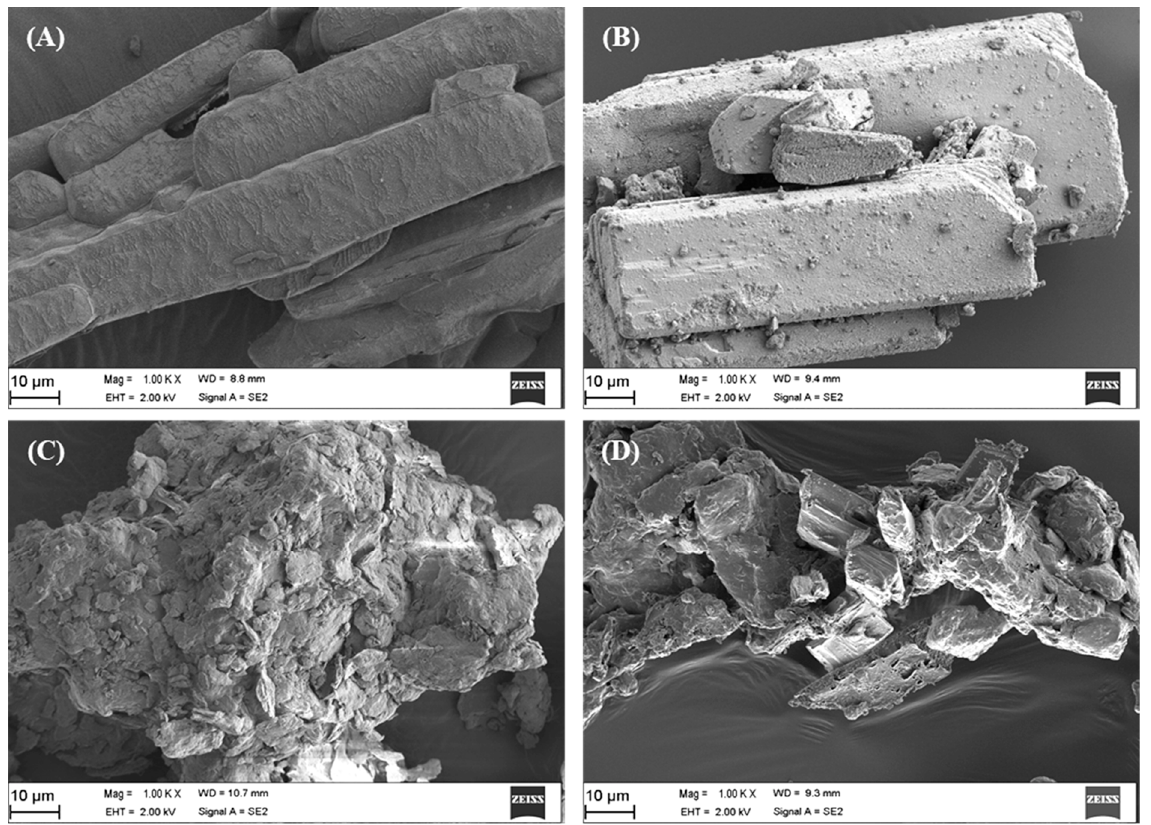
Figure 7. Scanning electron micrographs of: ( A ) pyrazinamide, ( B ) rifampicin, ( C ) placebo and ( D ) drug loaded suspension powder formulation captured at 1000×.